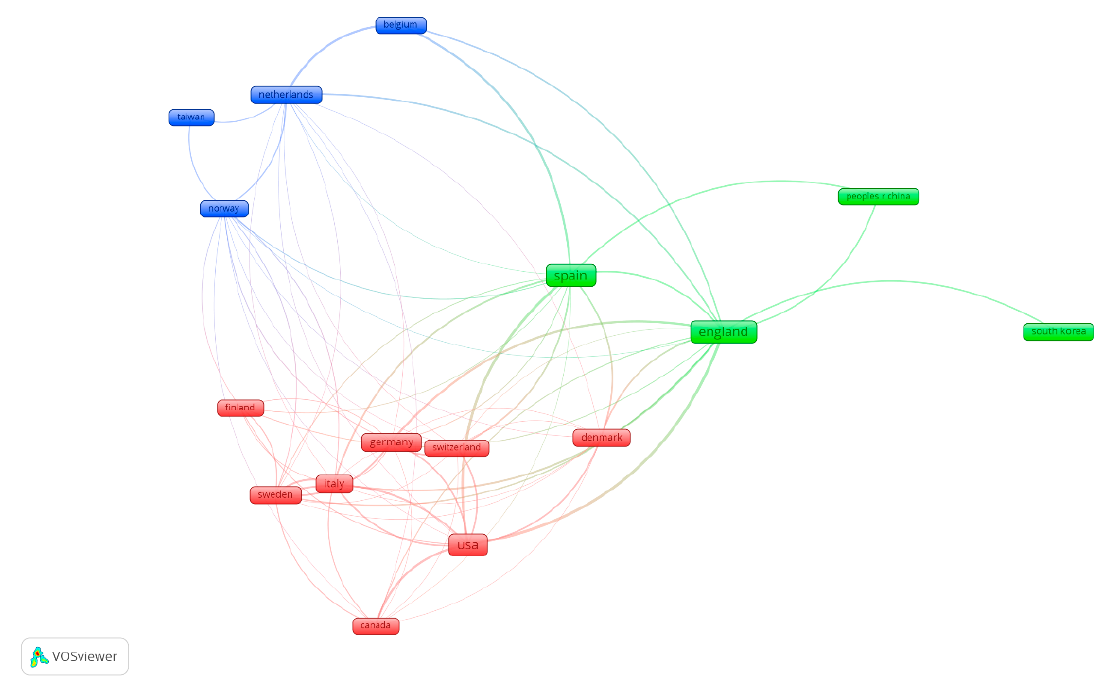
Figure 4. Collaboration between countries.